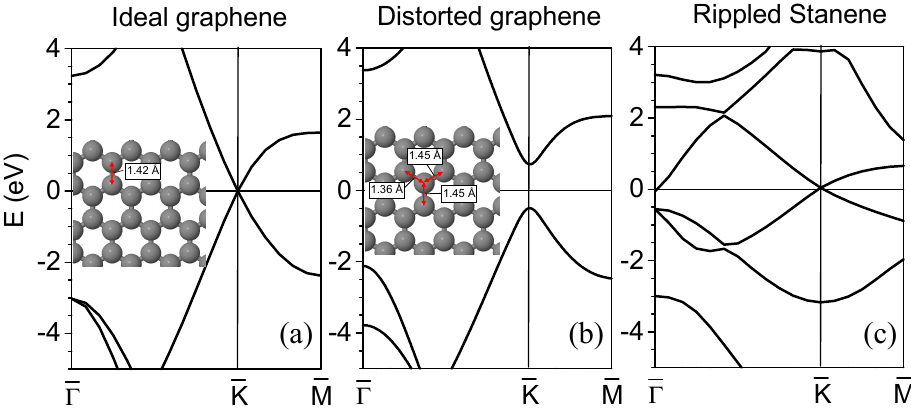
Figure 1. Band structures in vicinity of Fermi level for ( a ) an ideal free graphene; ( b ) distorted graphene monolayer; and ( c ) rippled Sn monolayer (stanene).